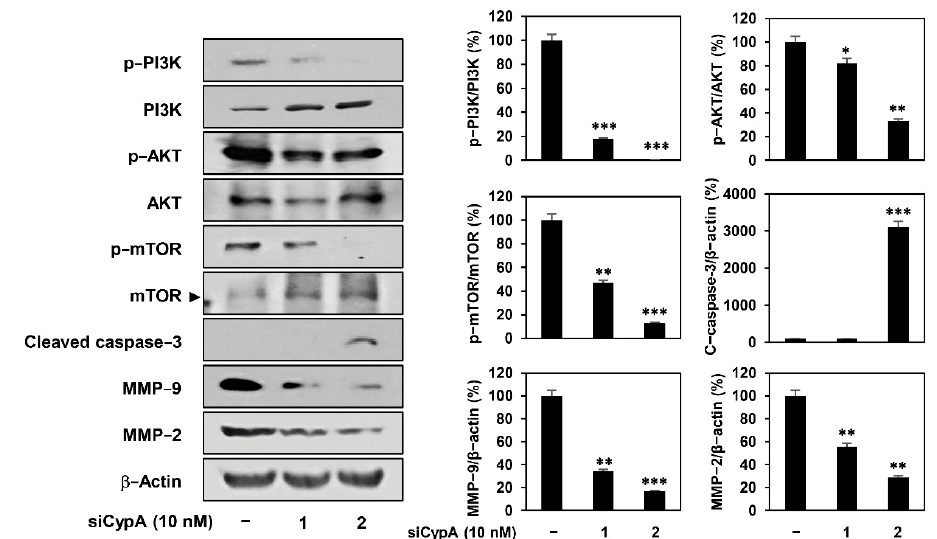
Figure 7. Effect of CypA knockdown on the PI3K/AKT/mTOR pathway in AGS cells. AGS cells were transfected with CypA siRNAs (10 nM) and incubated for 24 h. Protein levels were detected by western blot analysis and further quantified by densitometry. The level of β -actin was used as an internal control. * p < 0.05, ** p < 0.01, *** p < 0.001 versus the control.